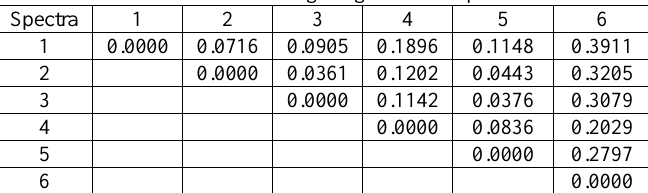
Table 3: CBD among Sorghum field